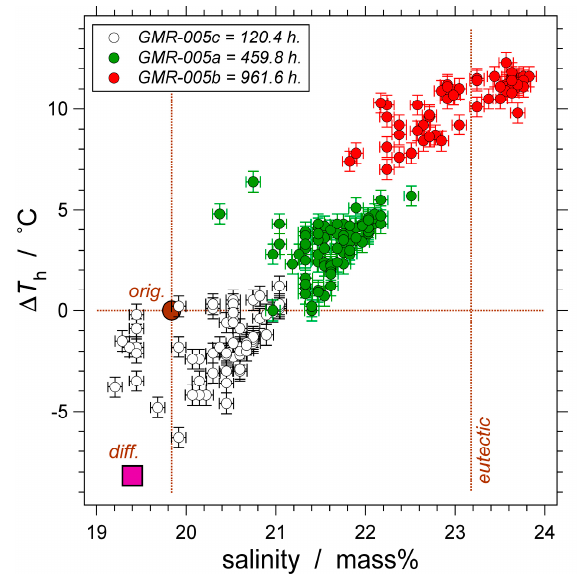
Figure 16. Modification of T h ( Δ T h ) versus salinity (mass% NaCl) of individual fluid inclusions after the re-equilibration experiments GMR-005c (open symbols), GMR-005a (green symbols) and GMR-005b (red symbols). The eutectic composition is illustrated with a vertical dashed line. The original synthetic fluid inclusions are located at 19.8 mass% NaCl and Δ T h = 0 ( orig .). The expected modification according to diffusion is illustrated with the purple square ( diff. ).